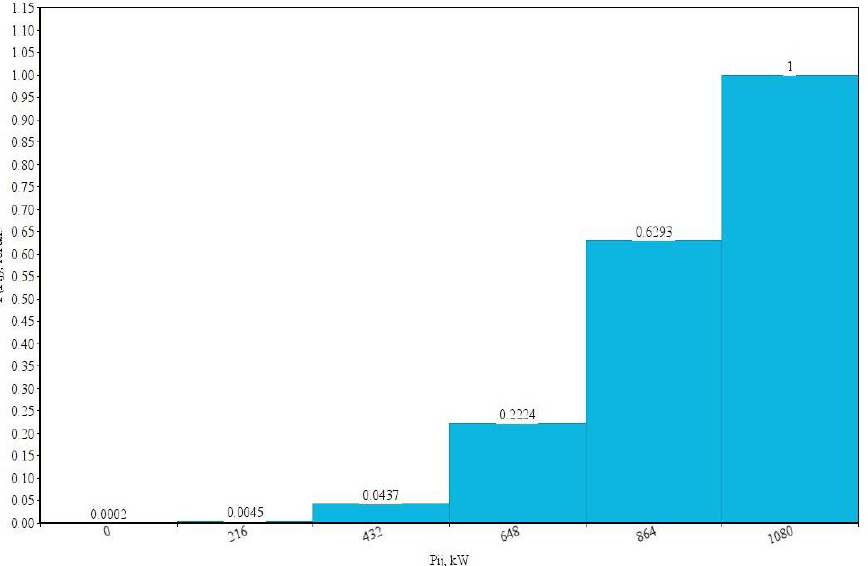
Figure 11. Step function of the probability distribution of the ordinates of the initial group ELC with the use of frequency control.